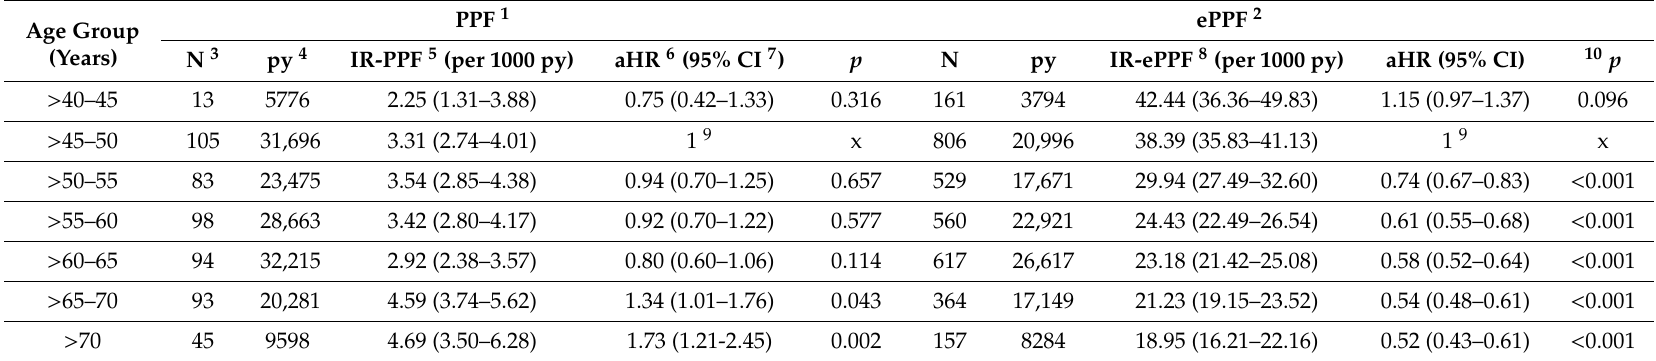
Table 2. Incidence rates of PPFs and ePPFs and adjusted hazard ratio including the 95% confidence